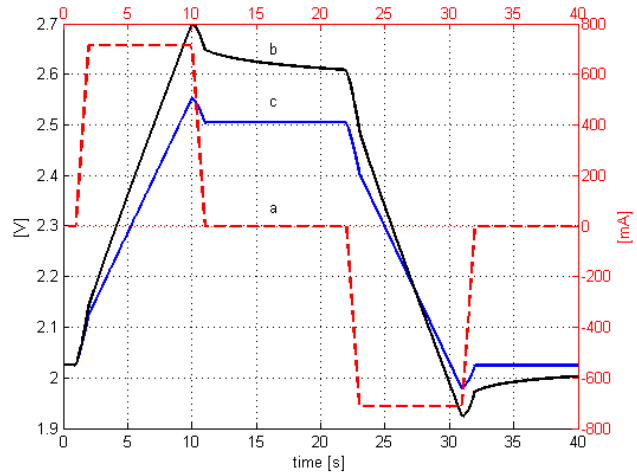
Figure 16. The current ( a ) and voltage ( b ) waveforms of SC of 10 F capacity and 2.7 V maximum voltage. Line “( c ): voltage response for simplified model C ( j ω ) = const.